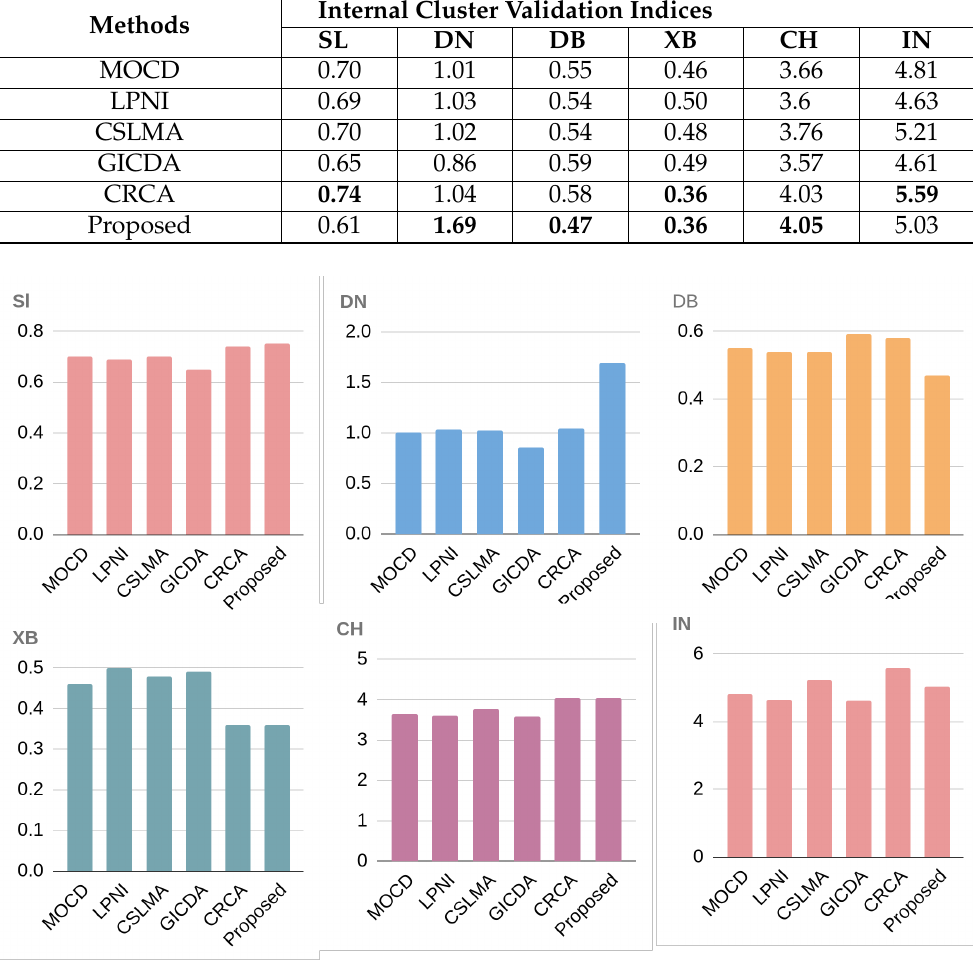
Figure 5. Average Comparison of Internal